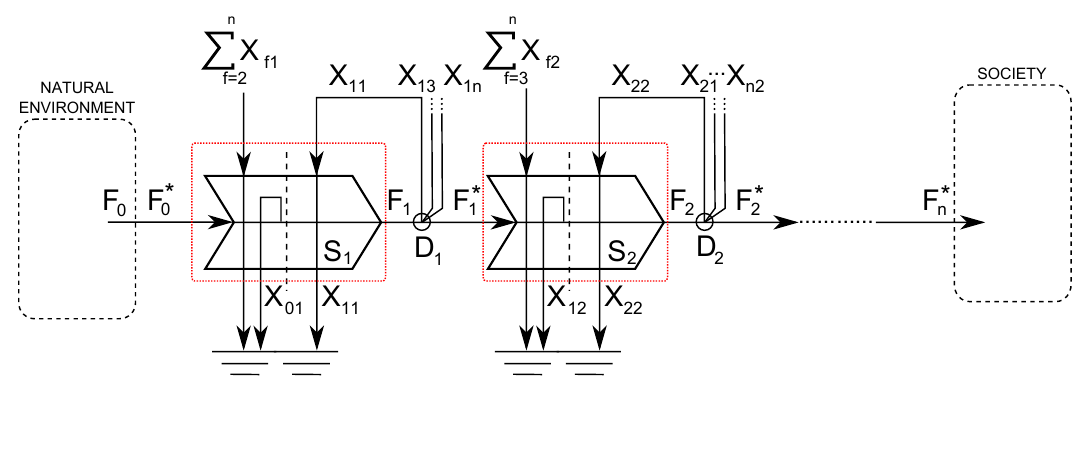
Figure 10. Energy production process with one pathway and n